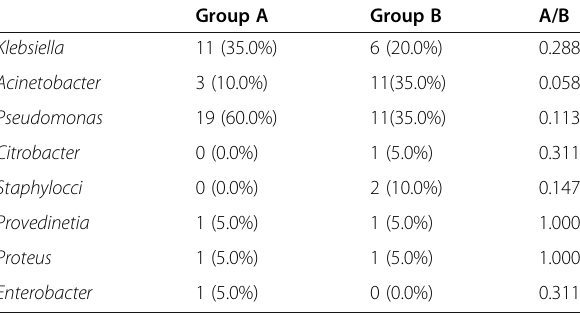
Table 3 Comparison between study groups as regards organisms revealed from cultures before treatment